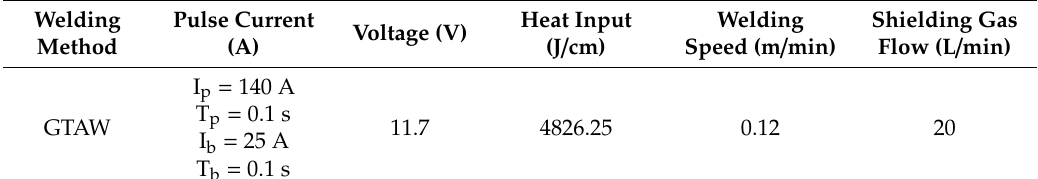
Table 3. Welding parameters of gas tungsten arc welding (GTAW).